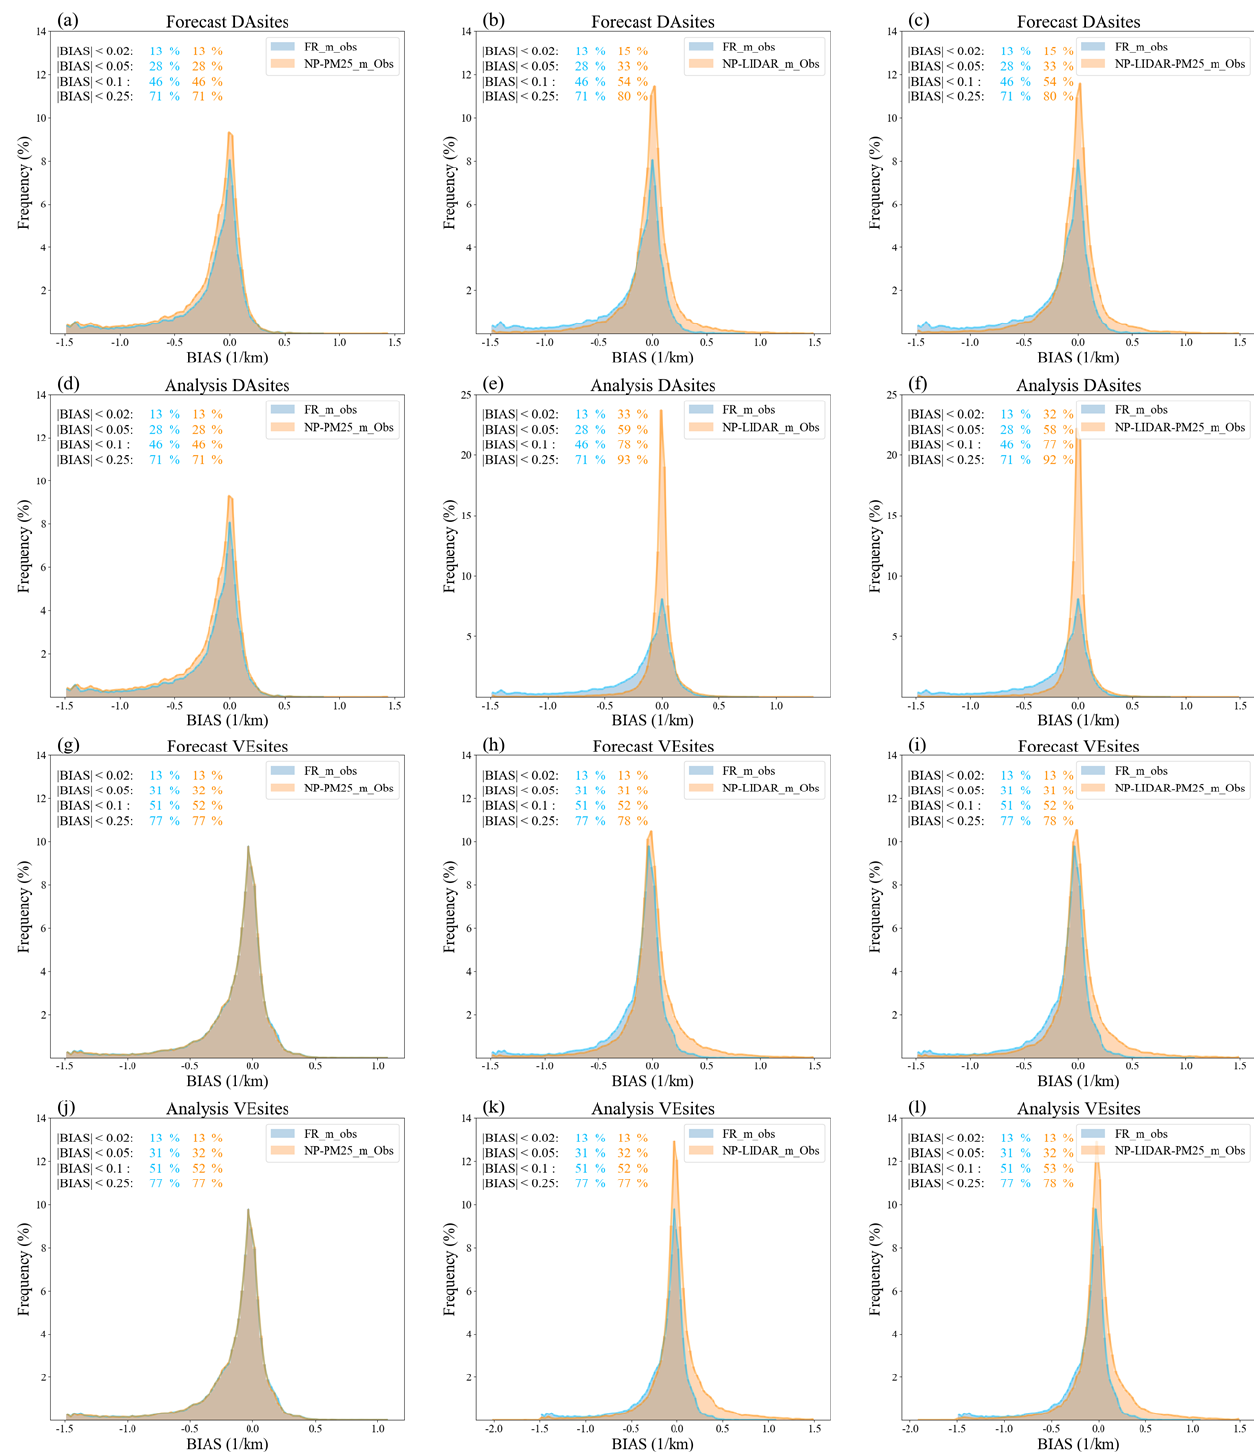
Figure 9. Frequency distributions of BIAS of forecasts of NP-PM25 versus FR (a) / (g) , forecasts of NP-LIDAR versus FR (b) / (h) , forecasts of NP-LIDAR-PM25 versus FR (c) / (i) , analysis of NP-PM25 versus FR (d) / (j) , analysis of NP-LIDAR versus FR (e) / (k) , and analysis of NP-LIDAR-PM25 versus FR (f) / (l) , which are averaged among DA sites/VE sites.